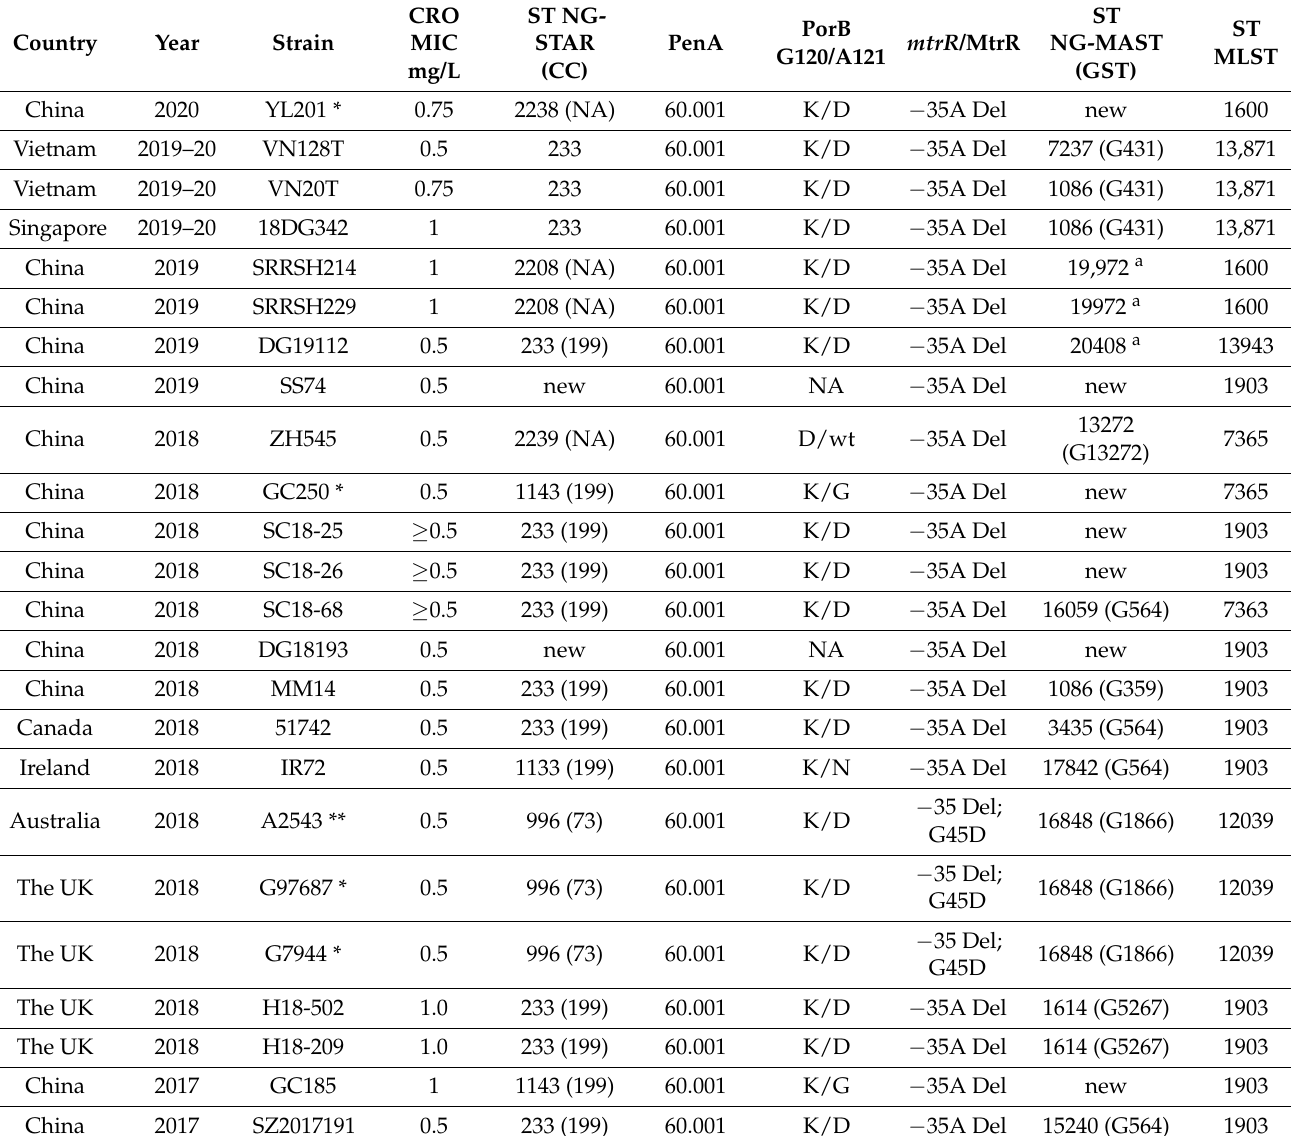
Table 1. N. gonorrhoeae strains with ceftriaxone MIC ≥ 0.5